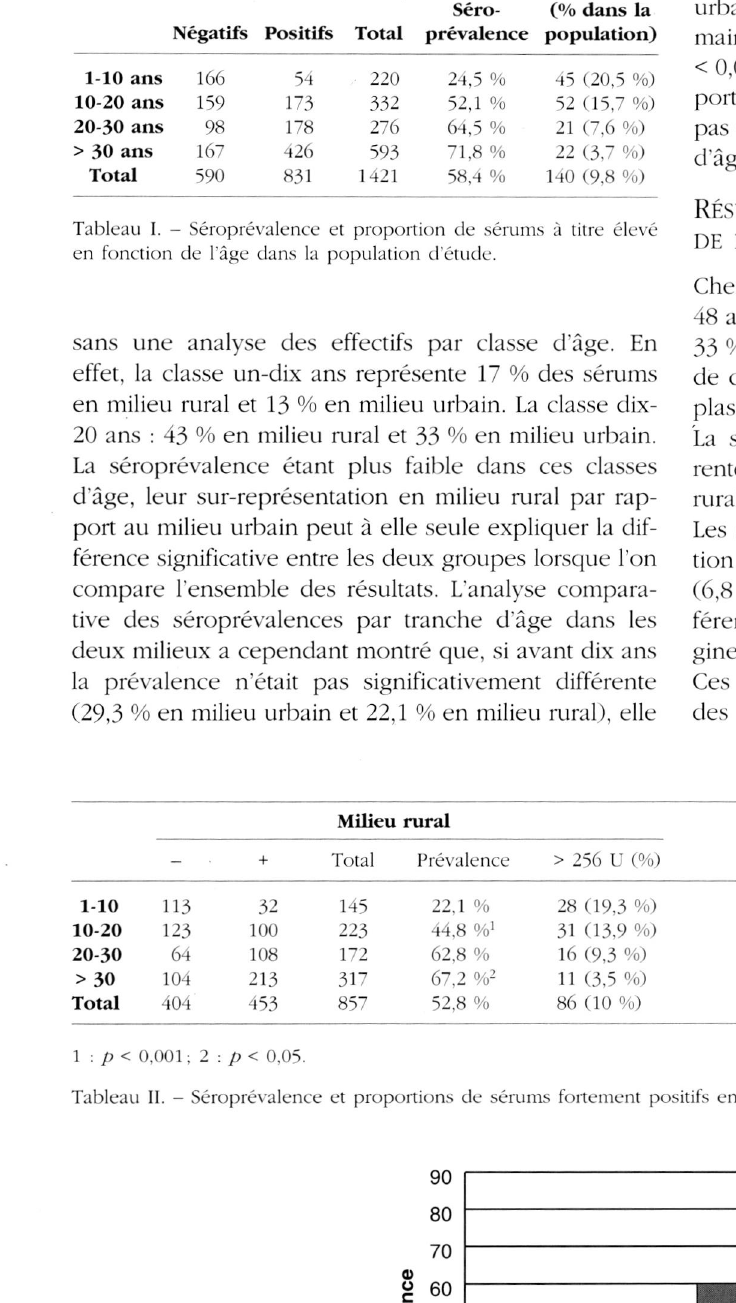
Tableau II. - Séroprévalence et proportions de sérums fortement positifs en fonction de l'âge, en milieu rural et